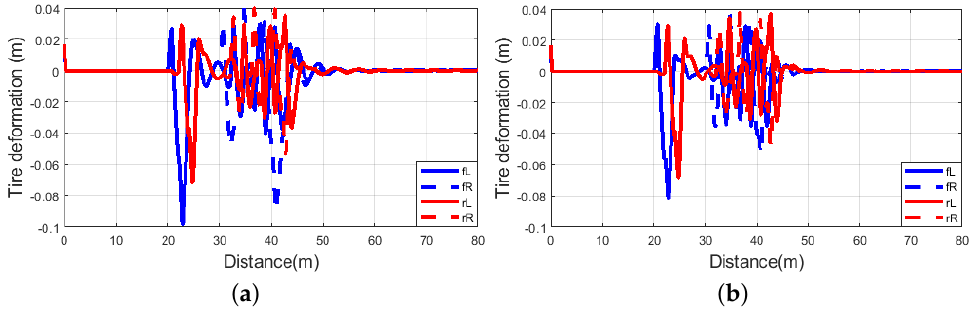
Figure 11. ( a ) Tire deformation of several bumps, ρ = 1. ( b ) Tire deformation of several bumps, ρ = 0.